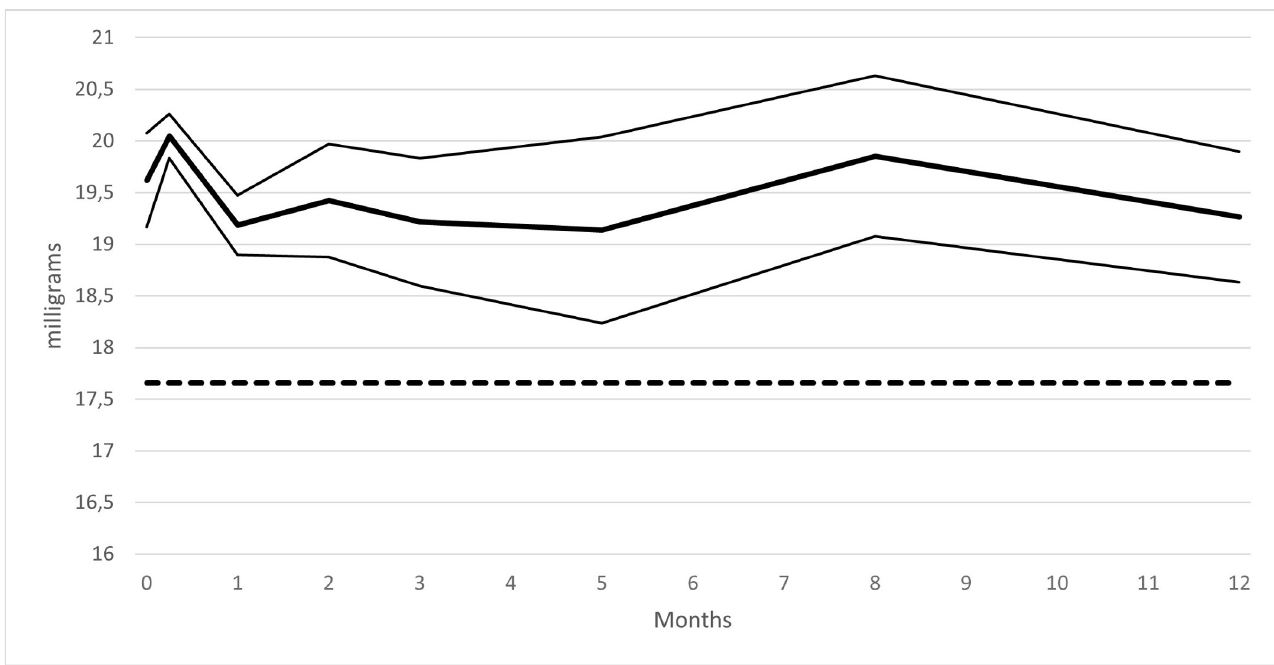
Fig 2. Erythromycin capsules stability study under ambient storage